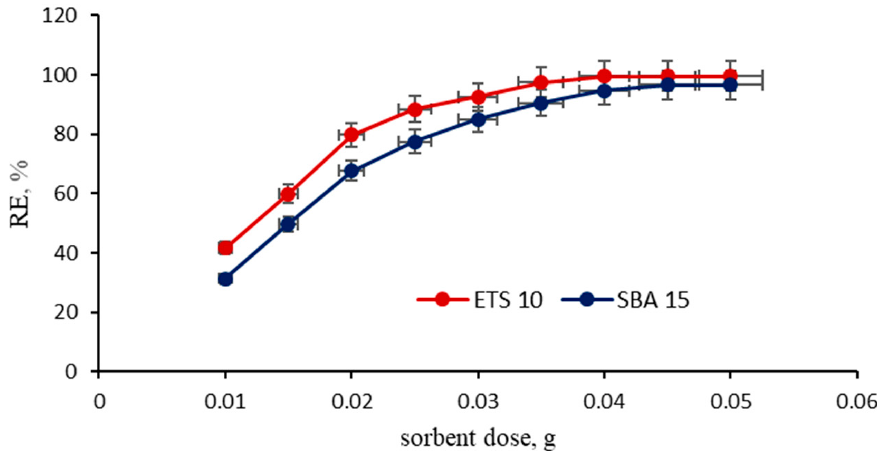
Figure 2. Influence of adsorbent dose on the removal efficiency of SBA-15 and ETS-10 adsorbents toward Cu(II). (C i 10 mg/L, time 60 min, temperature 23 °C).